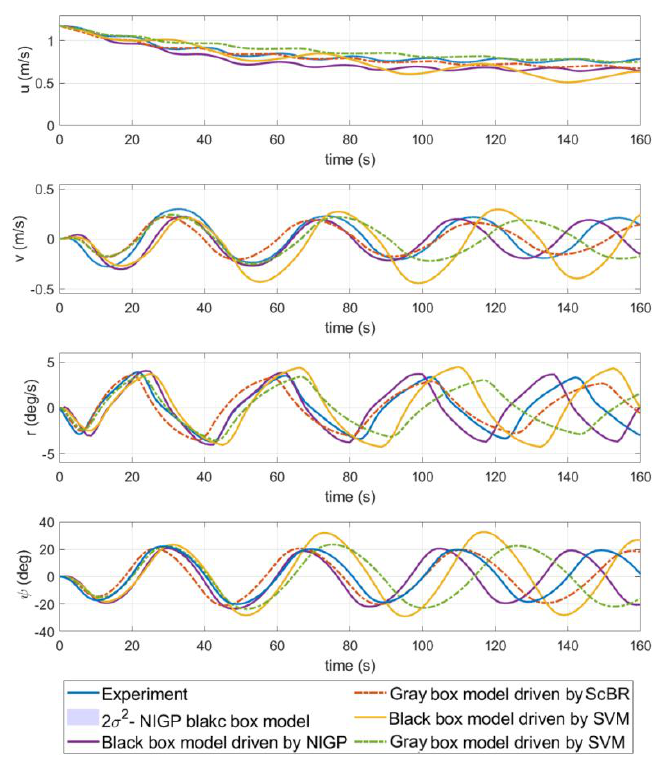
Figure 5. Comparisons of results of the ship predicted motion; the 30°/5° zigzag test.